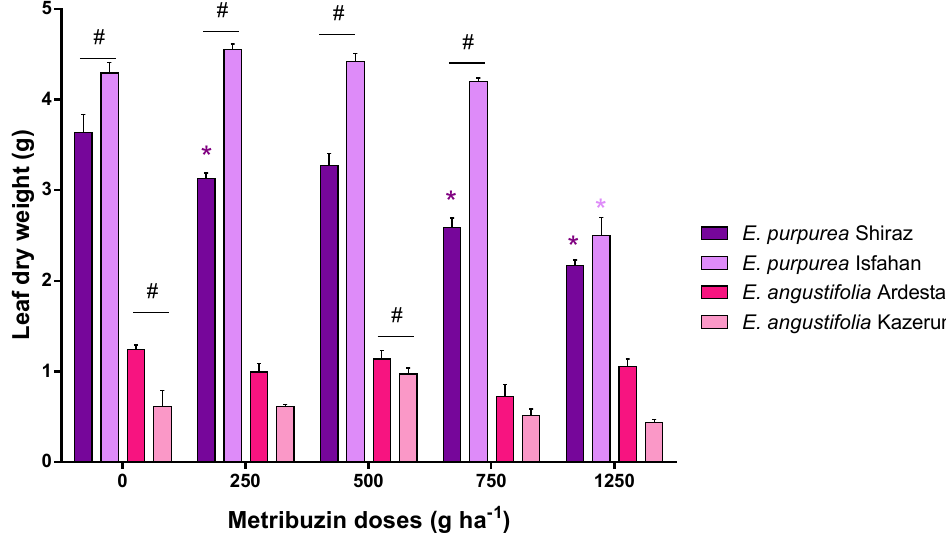
Figure 2. Effect of different metribuzin doses on leaf dry weight of Echinacea purpurea and Echinacea angustifolia species. Data are shown as the mean ± SEM, and ordinary two-way ANOVA followed by Dunnett’s multiple comparisons test was used for statistical significance; * p < 0.005 vs. control (0 g ha − 1 metribuzin). Significant differences between Echinacea cultivars are indicated with #. These results suggest that application of high doses (750–1250 g ha − 1 ) of metribuzin adversely affects the biomass accumulation in Echinacea species.